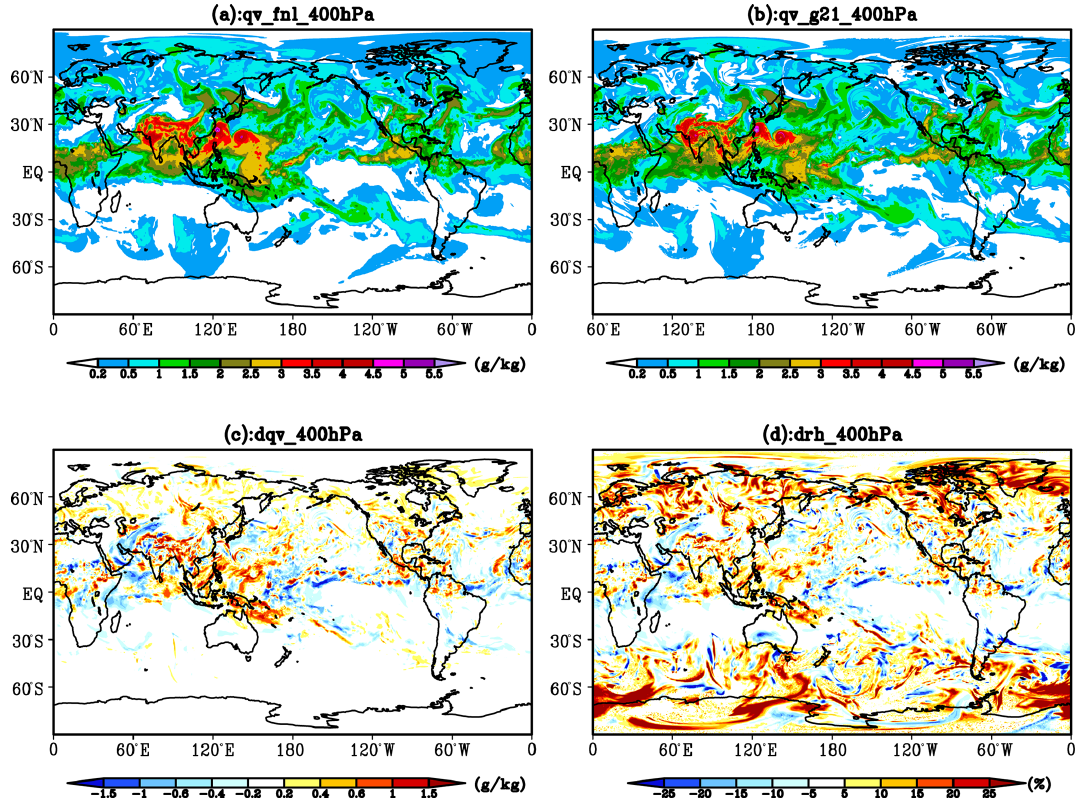
Figure 6. Distribution of water vapor content (WVC) (a, b) simulated by F00 and G21, and the differences of WVC (c) and relative humidity (RH) (d) between F00 and G21 (F00-G21) at 400hPa in their initial fields. WVC and RH are given in units of gkg − 1 and %,